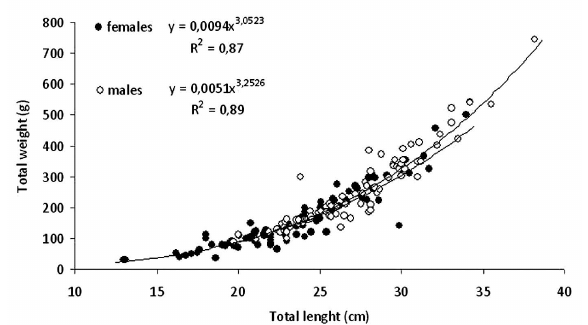
Fig . 3. – Length-weight relationship of Labrus mixtus sampled in the central Adriatic.